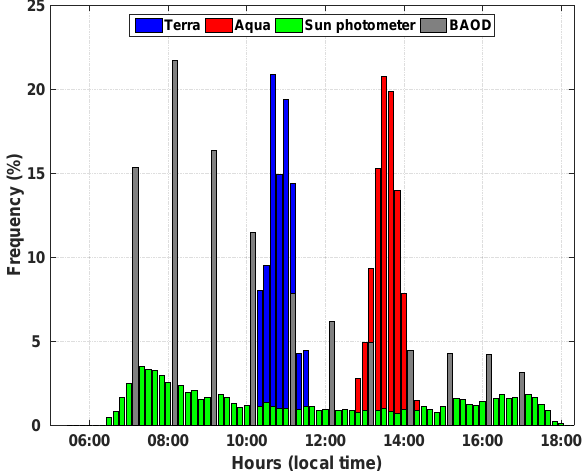
Figure 2. Frequencies of the time of day (local time) overpass of Terra and Aqua (blue and red respectively). Camagüey’s sun pho- tometer site is in a radius of 25km for the period 2001 to 2015. In green are the time frequencies for the Camagüey’s sun photometer observations in the period 2008 to 2014. In addition, the time fre- quencies for the direct radiation observations are used to calculate the BAOD. The bar width is 10min for Terra, Aqua and the sun photometer and 1h for the